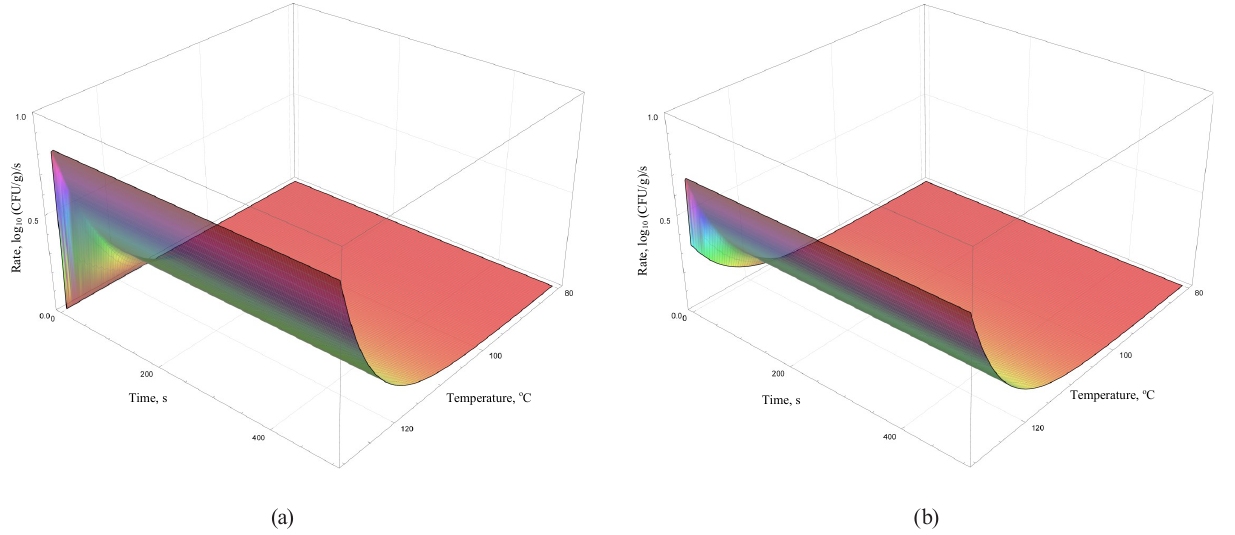
Figure 11 Model of rate dynamics for microbial death kinetics of A. acidoterrestris during heat treatment. (a) Fermi model,